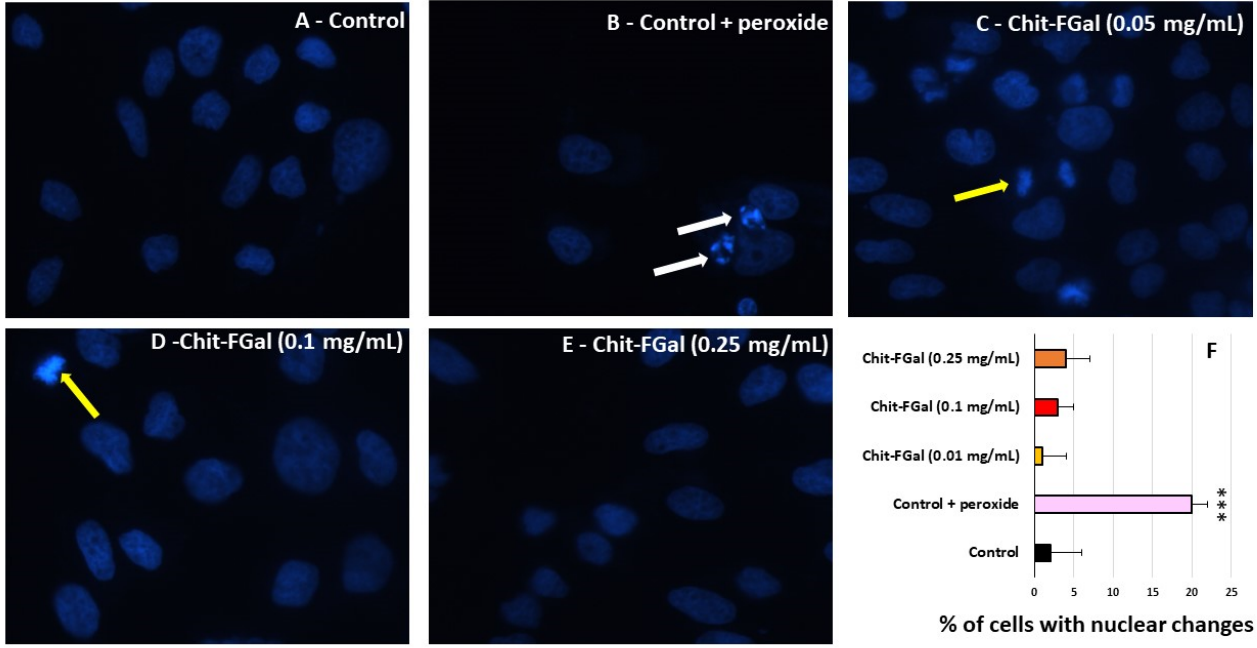
Figure 10. Morphological changes of 3T3 cells incubated with Chit-FGal and hydrogen peroxide (H 2 O 2 ) for 6 h followed by DAPI staining. ( A ) Fluorescence microscope photographs of untreated cells; ( B ) cells treated with H 2 O 2; ( C ) cells treated with 0.05 mg/mL Chit-FGal + H 2 O 2 ; ( D ) cells treated with 0.1 mg/mL Chit-FGal + H 2 O 2 ; ( E ) cells treated with 0.25 mg/mL Chit-FGal + H 2 O 2 ; ( F ) DAPI staining quantification—Images were captured from ten different fields and about 100 cells were counted for each field. White arrows indicate nuclear fragmentation and/or chromatin condensation. Yellow arrows indicate cell division. Magnification × 400. *** indicates the significant difference between the control and samples ( p < 0.05).